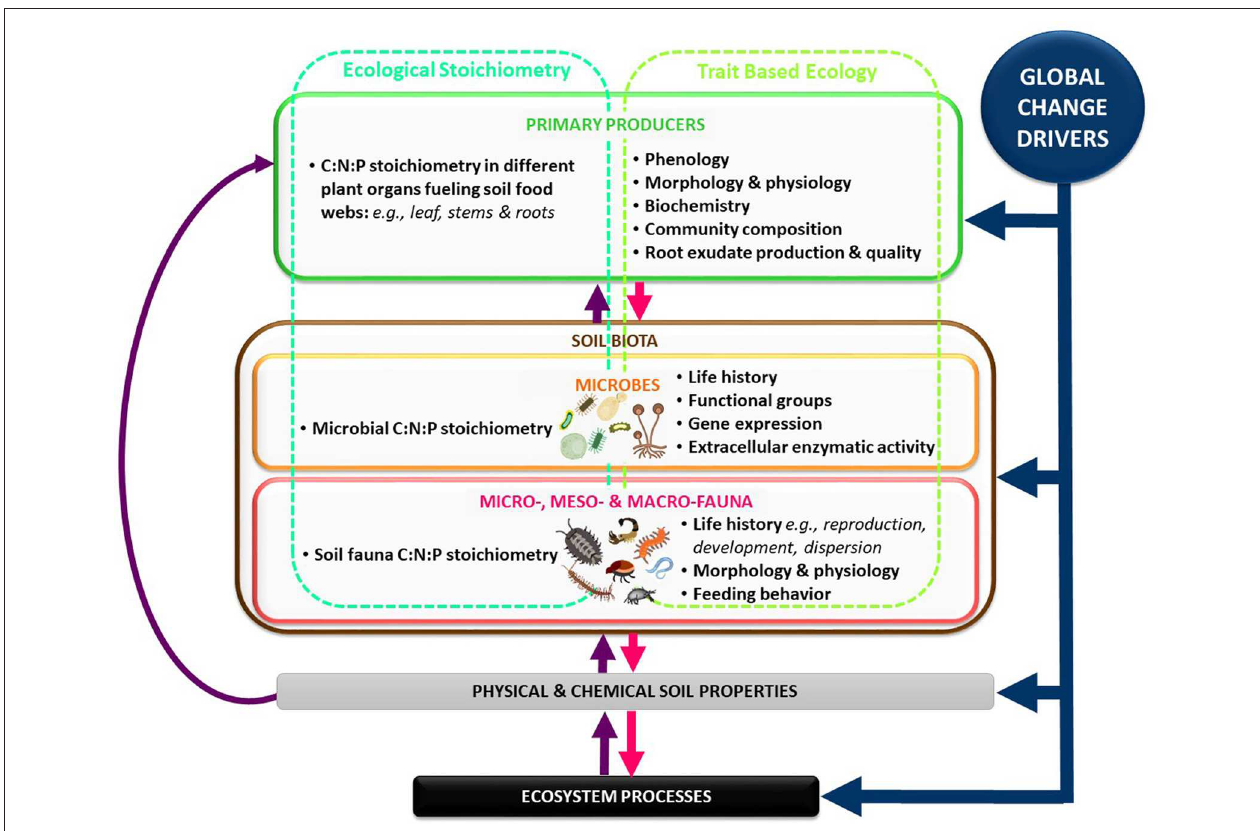
FIGURE 2 | Simplified conceptual model of global change driver effects on soil biota in forest ecosystems. Blue arrows: effects of global change drivers on forest ecosystem compartments. Purple and fuchsia arrows: links between producers, consumers, soil properties and ecosystem processes. Turquoise column: ecological stoichiometry measurements. Green column: trait-based ecology